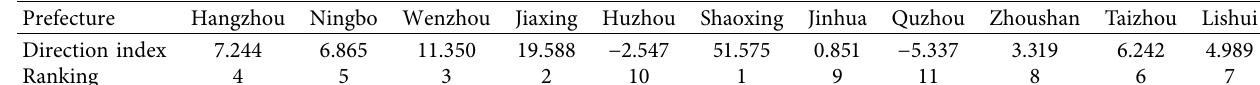
Table 7: Direction indices of all prefectures and their rankings.